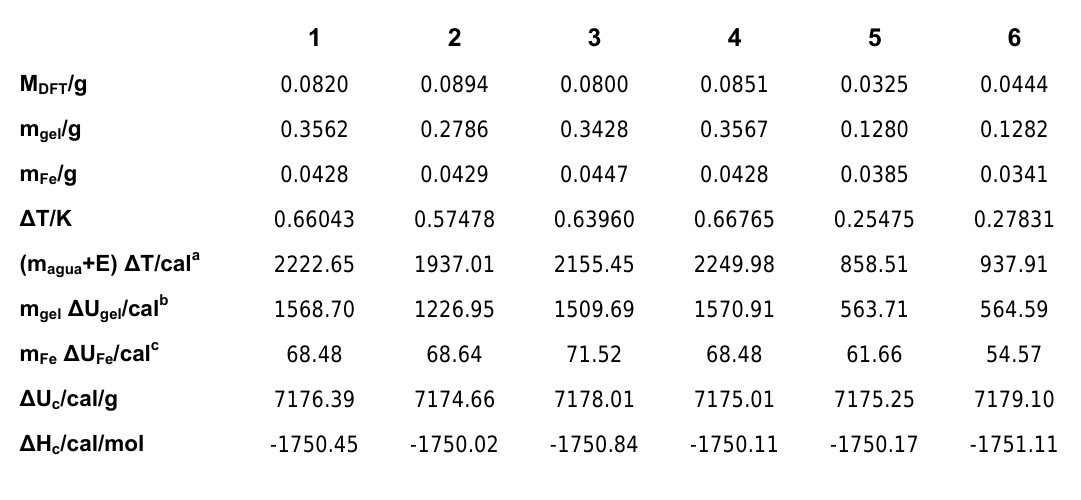
Typical Results of the Combustion Experiences